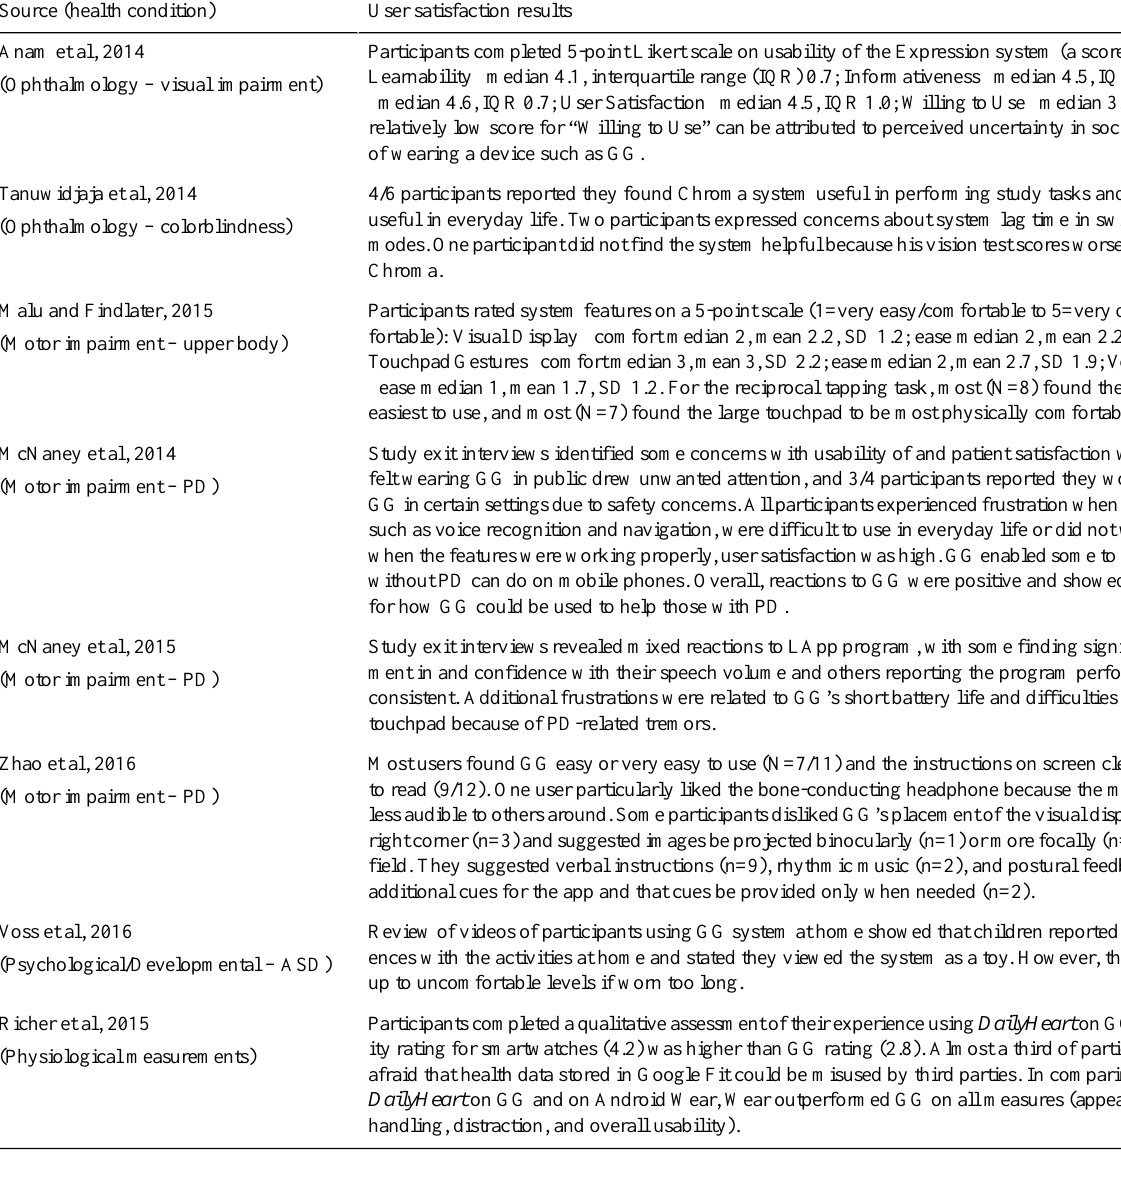
Table 5. Feasibility and acceptability of Google Glass as patient-centered interventions.